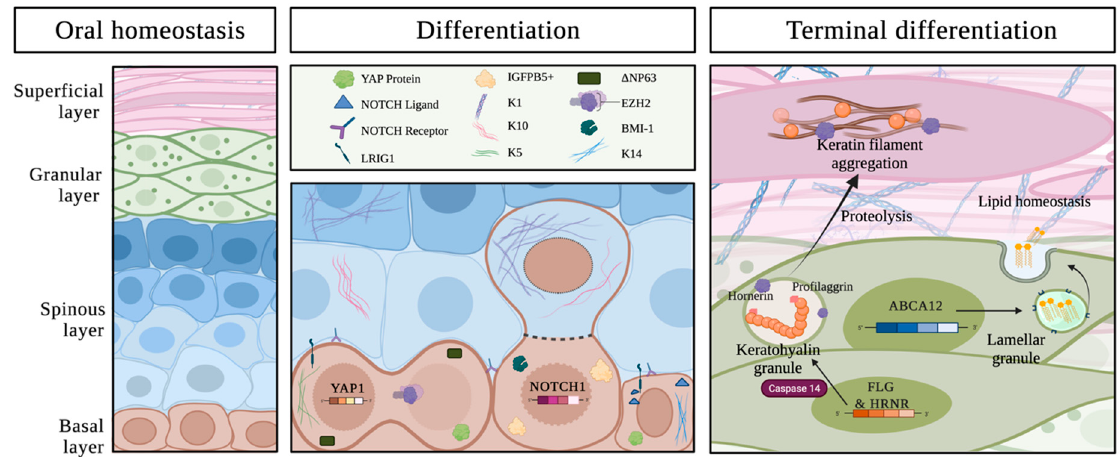
Figure 1. Schematic representation (original figure) of the oral layers in homeostasis ( left ) with a highlight of the basal layer depicting major players in epithelial differentiation ( middle ) and those regulating terminal differentiation in the superficial layer ( right ).